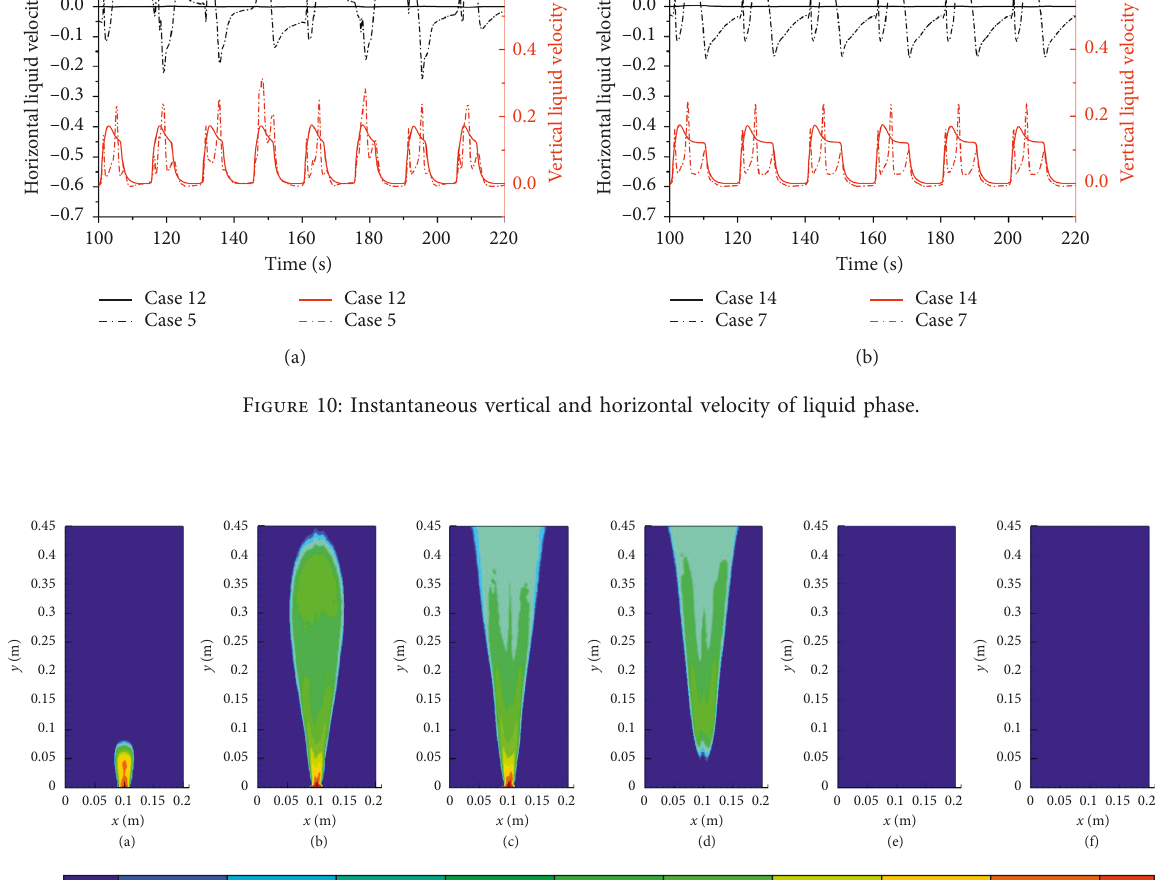
phase. With increasing anaerobic time, the flow field structure became complicated and the number of vortexes and distribution changed. When the an- aerobic time was below 9 s, the vertical velocity distributions of the gas phase and liquid phase were approximately symmetric, and the gas holdup dis- tribution was columnar. The gas holdup slightly decreased with increasing anaerobic time at the same ratio of aeration time to anaerobic time; and the gas holdup decreased with decreasing ratio of aeration time to anaerobic time.